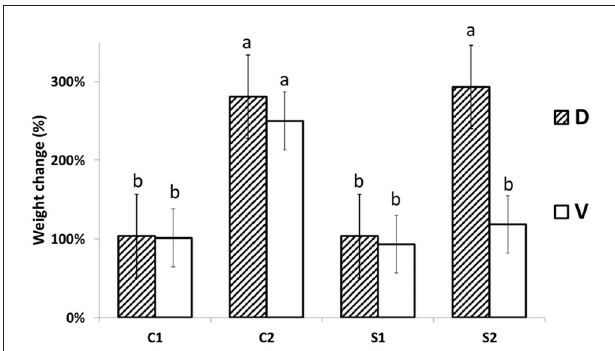
FIGURE 1 | MDE growth changes. MDE relative (%) fresh weight changes (the day after stress + 1/day after stress 0) are significantly lower in Viking (V) in comparison to Cadeli (D) only after 7 days of cultivation under stress (S2). Controls and treated samples (C1 and S1, respectively), for the first sampling (24h after stress); C2, S2 arecontrols and treated samples seven DAS, respectively. Homogeneous groups above the error bars indicate significant changes between cvs. by the Student’s t -test ( p < 0.05). Only different letters show significantly different